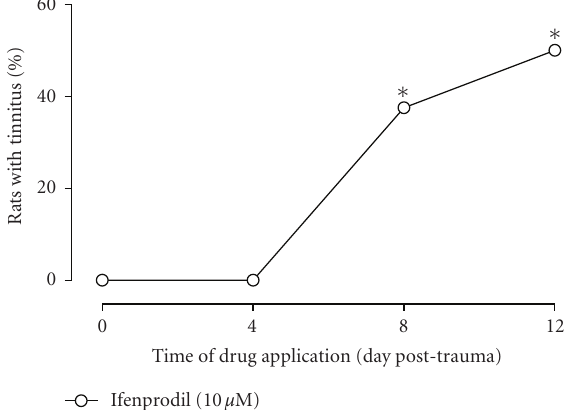
the absence of the tone, P < .001; not di ff erent from the